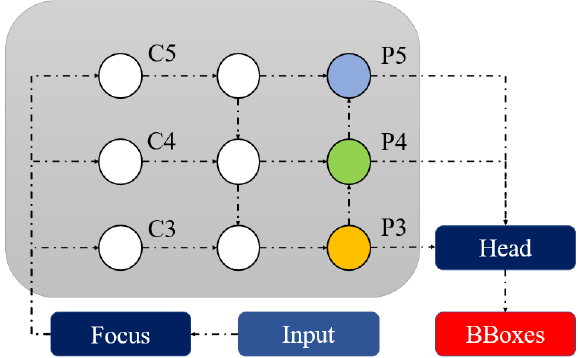
Figure 6. Representation of feature fusion of YOLOv5 model.